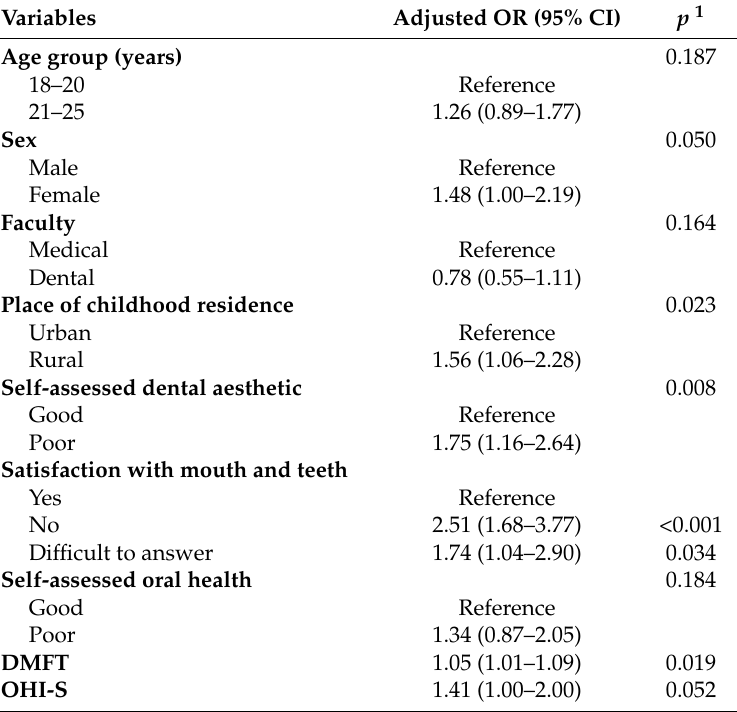
Table 5. Adjusted odds ratio of having low oral health-related quality of life in the study sample by selected